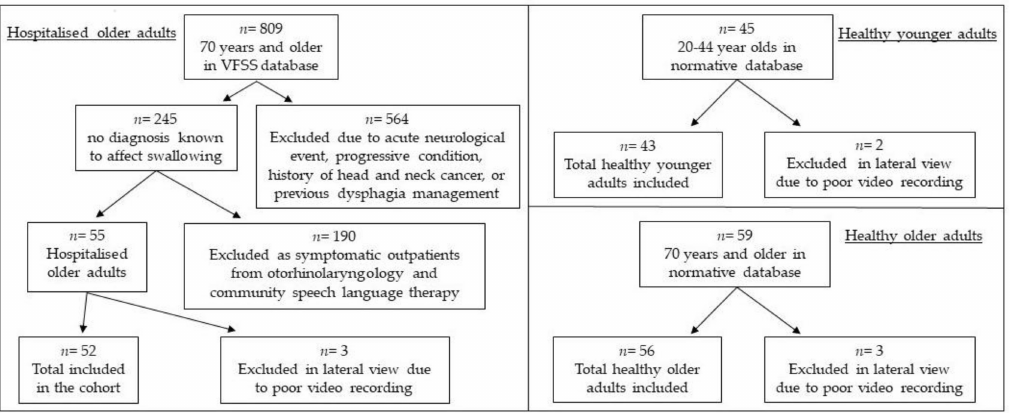
Figure 1. Reasons for lateral video exclusions in each cohort: hospitalized older adults, healthy younger adults, and healthy older